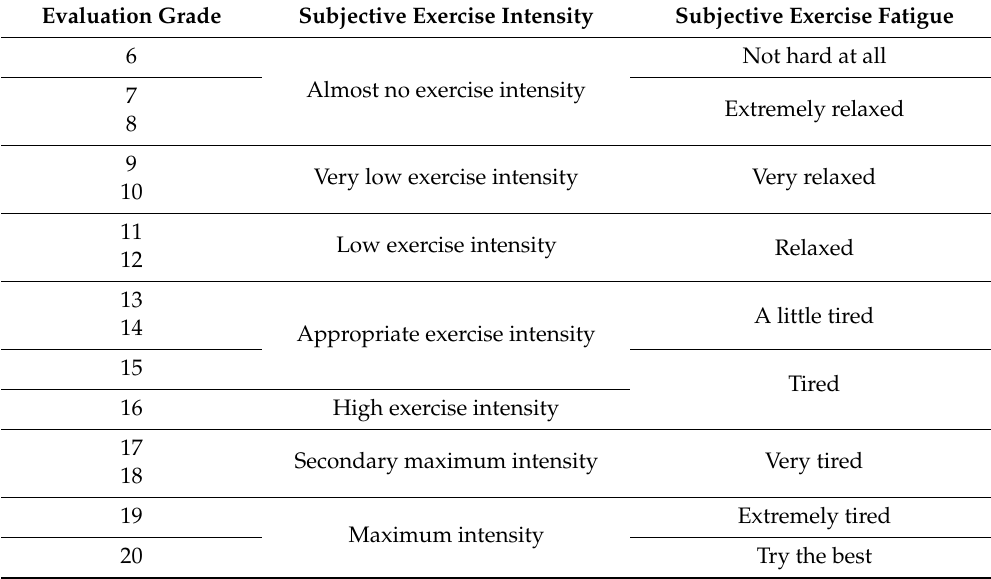
Table 3. Subjective perceived exertion scale (RPE).